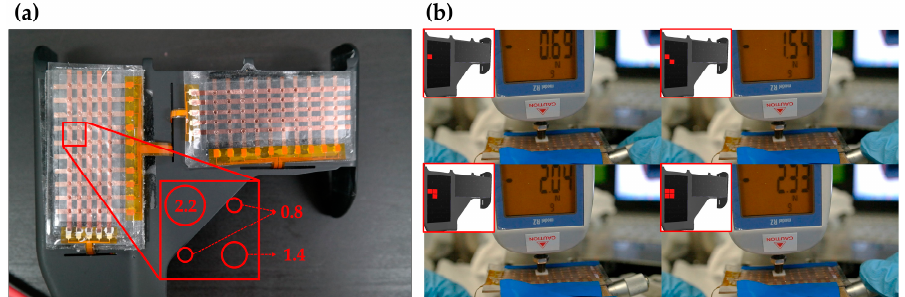
Figure 9. The digital type tactile sensor; ( a ) A photo of the extended sensor; ( b ) The various force responses according to the hole size.